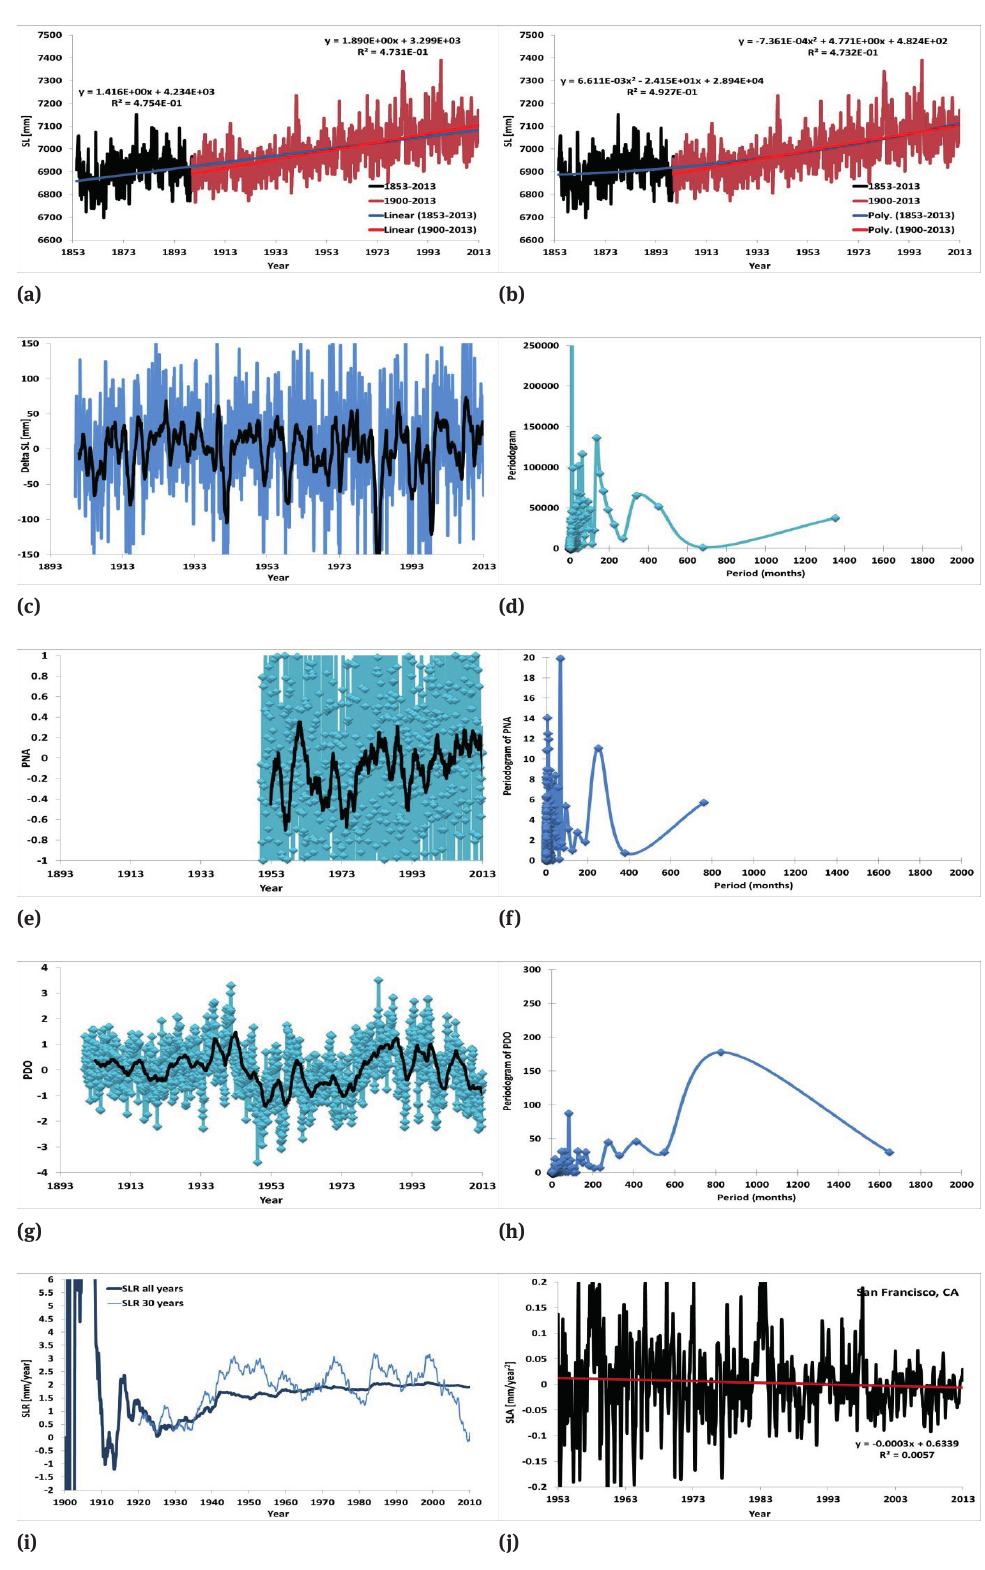
Fig. 4. San Francisco, CA tide gauge: a) and b) linear and parabilic fitting of the data 1856-2011 and 1900-2011. c) oscillations about the linear trend of the shorter record. d) Periodogram of these oscillations. e) PNA oscillations. f) periodogram of the PNA. g) PDO oscillations. h) periodogram of the PDO. i) time hystories of the rates of rise of sea level computed by using all the data available at a certain time and 30 years. j) time rate of change of the of the rate of rise of sea level computed by using all the data available at a certain